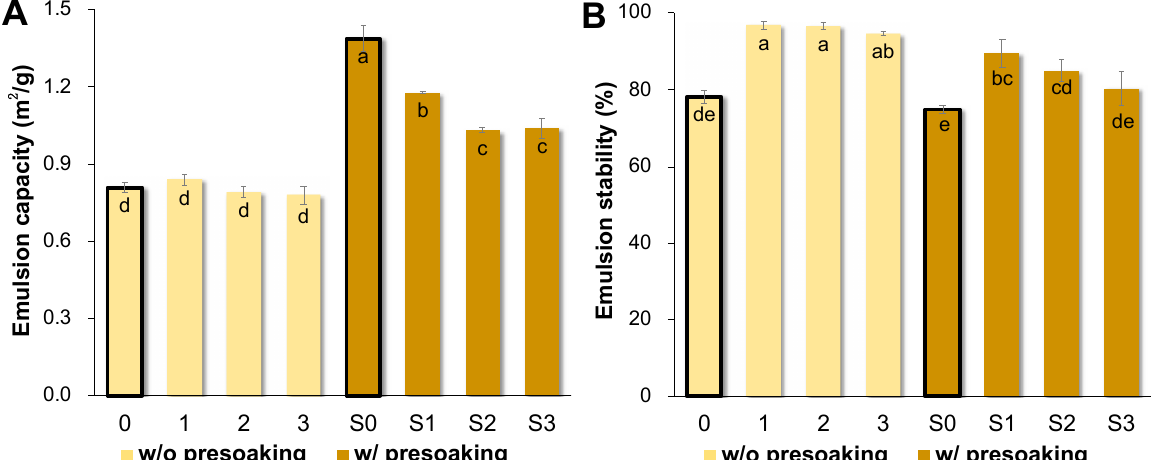
Figure 5. ( A ) Emulsion capacity and ( B ) stability of the AQ prepared from different seed types. Bold bar graphs are each group of controls (0 and S0), respectively. All emulsions prepared in this study dispersed easily in water and were thereby confirmed to be oil/water emulsions. Each value marked with a different letter (a–e) is significantly different ( p < 0.05) from the others marked with a different letter according to Tukey’s test.